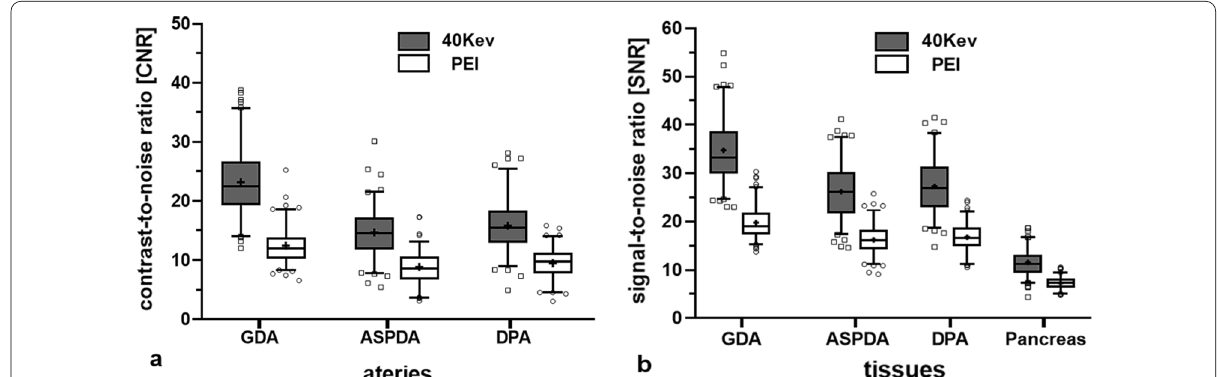
Fig. 2 Box‑and‑whisker plots of the differences in CNR (a) and SNR (b) between 40‑keV MEI ( the horizontal line indicates the median and the cross indicates the mean. Whiskers show the 5 and 95 percentiles; outliers are indicated by squares and